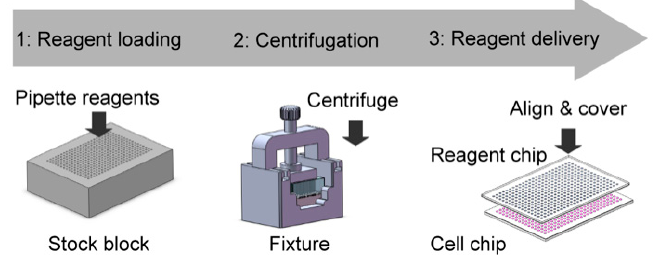
Figure 3. Operating procedure of the NanoCLD. First, reagents were pipetted from 96-plates to the stock block using an adjustable tip spacing pipette. Second, the reagents were dispensed into the reagent chip in the fixture under the centrifugal force. Third, the dispensed reagents were further delivered to cells by aligning and covering the reagent chip upside down onto a cell chip.